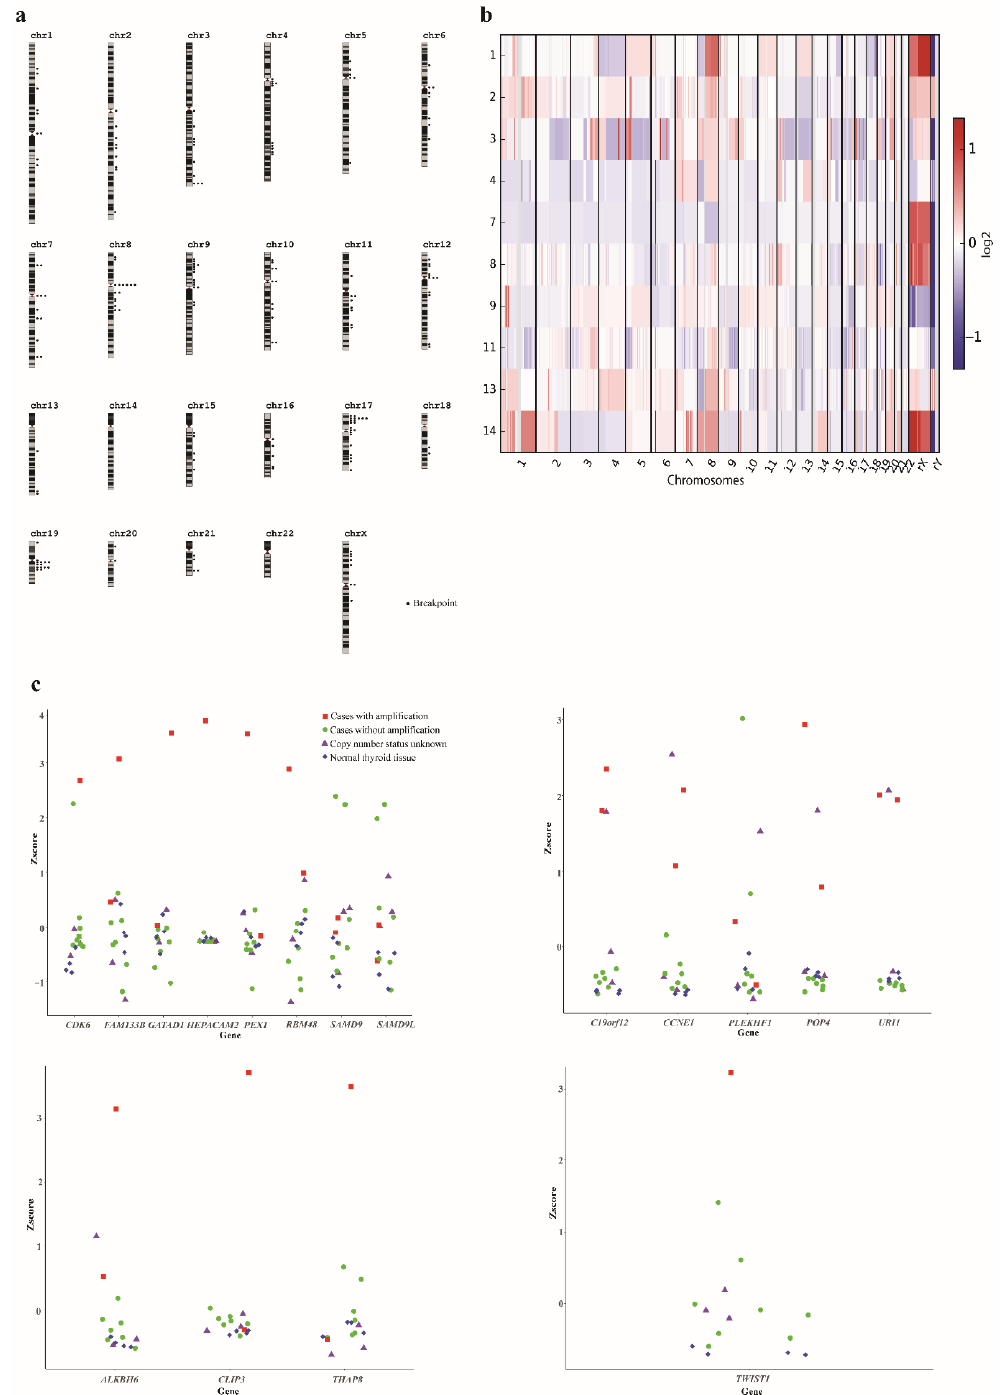
Figure 1. Detection of copy number variants in anaplastic thyroid cancer (ATC). ( a ) Breakpoint map of 10 primary ATC cases based on whole exome sequencing. Breakpoints were defined as a change in copy number state. A large number of breakpoints in centromeric regions were seen. ( b ) Heat map of copy number aberrations in 10 primary ATC cases. Polyploidy and large variations in chromosomal copy number were seen. ( c ) Expression of genes in amplified regions in all ATC cases and normal thyroid tissue.